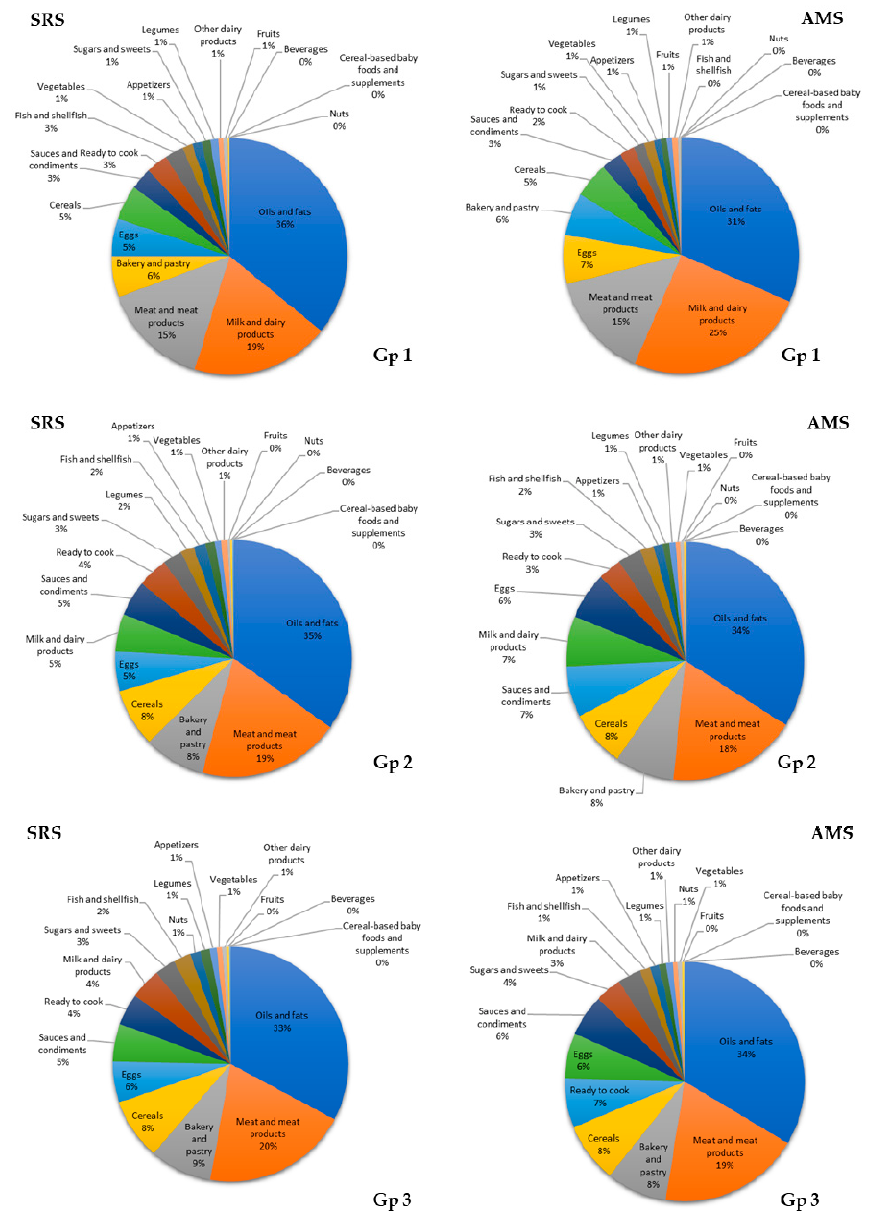
Figure 3. Contribution (%) of the 18 food groups to linoleic acid (LA) intake in the EsNuPI study population (Spanish Reference Cohort (SRS) and Adapted Milk Consumers Cohort (AMS)) according to age group (( Gp 1 ), 1 to < 3 years; ( Gp 2 ), 3 to < 6 years; ( Gp 3 ), 6 to < 10 years).